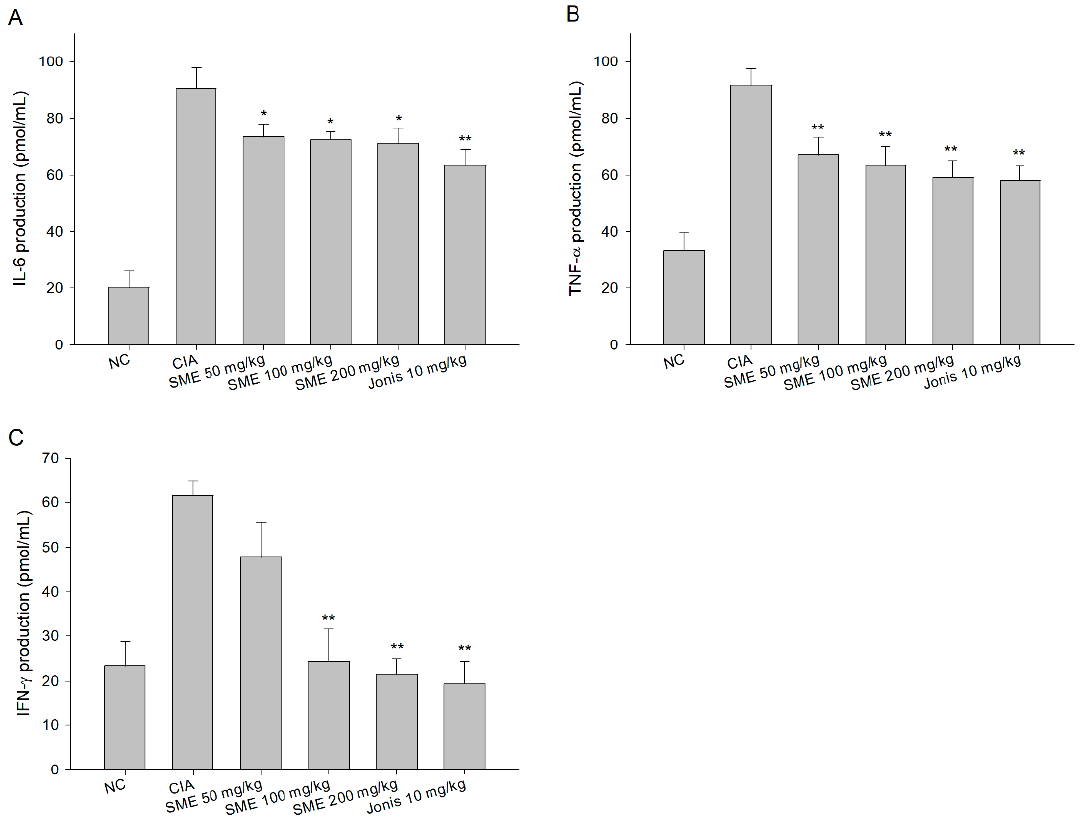
Figure 3. Effects of the Sargassum muticum extract on ( A ) interleukin (IL)-6, ( B ) tumor necrosis factor (TNF)- α , and ( C ) interferon (IFN)- γ production in serum. *: significantly different from the CIA group ( p < 0.05), **: significantly different from the CIA group ( p < 0.01).